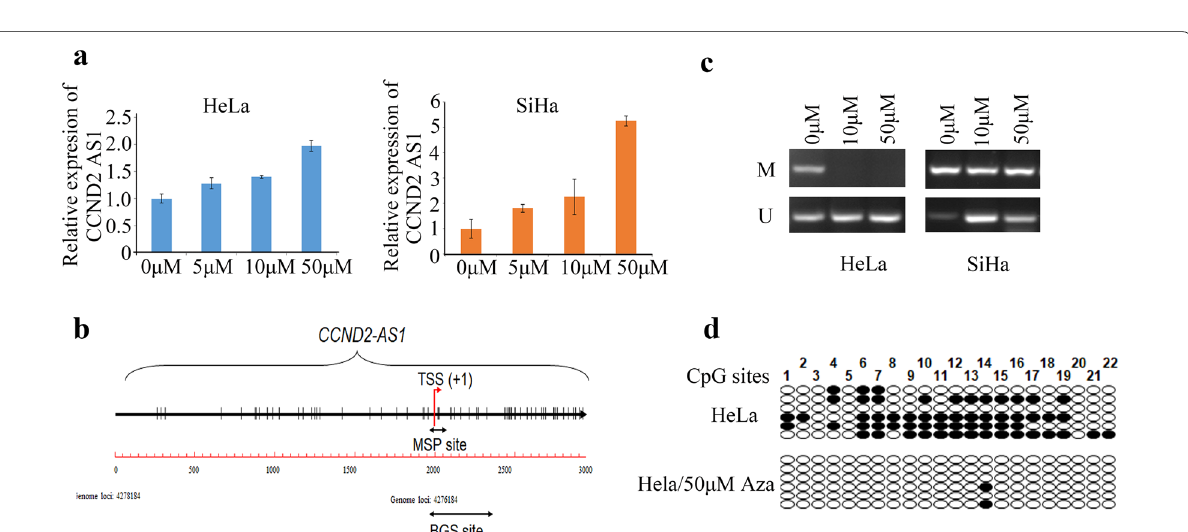
Fig. 6 Silencing of CCND2 AS1 due to its promoter CpG methylation in cervical cancer. a CCND2 AS1 expression was restored when the HeLa and SiHa cells were treated with 5΄-Aza from 5 μM to 50 μM. b Diagram of the CCND2 AS1 gene promoter with the transcription start site (TSS) indicated. The short black double-headed arrow represents the location of the fragment detected by the MSP and BGS assay. c Methylation status of the CCND2 AS1 promoter was detected by Methylation-specific PCR in HeLa and SiHa cell lines. M showed methylation-specific primer amplification, and U showed unmethylation-specific amplification. d Bisulfite genomic sequencing analysis was performed spanning the CCND2 AS1 core promoter and exon 1 in HeLa cell line. Twenty-two individual CpG sites within the CCND2 AS1 promoter were sequenced. Each row represents a single sequence; white circle indicates unmethylated CpG sites and black circle indicates methylated CpG